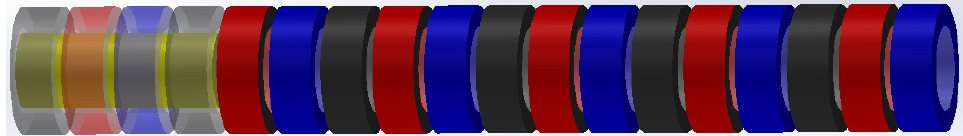
Figure 4. 3D representation of three-phase asynchronous induction coil launcher.